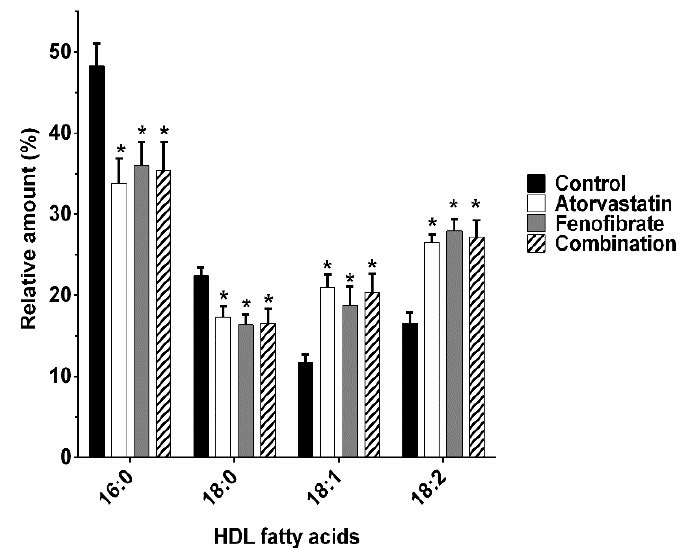
Figure 2. The relative amount of total HDL fatty acids shifted from saturated fatty acids towards unsaturated fatty acids with atorvastatin, fenofibrate, and the combination treatment. HDL were used to extract the lipids and the fatty acids composition was determined by gas chromatography–mass spectrometry. The fatty acids were identified by their retention time and mass spectrum; 16:0, palmitic acid; 18:0, stearic acid; 18:1, oleic acid; 18:2, linoleic acid. Data are mean ± standard error, n = 6. * ANOVA test, p < 0.05 vs. control rabbits.